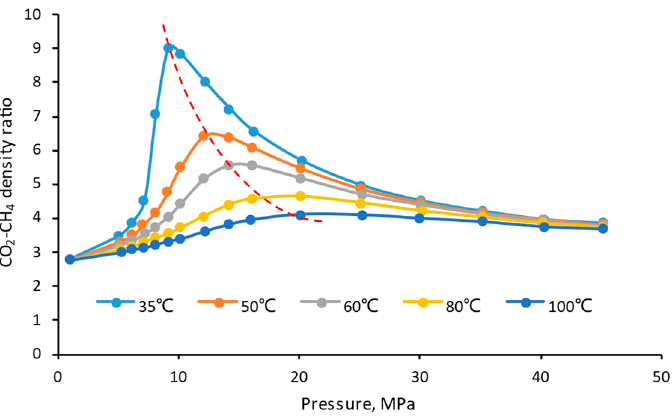
Figure 9. The CO 2 -CH 4 density ratio variation curve under different temperatures and pressures.